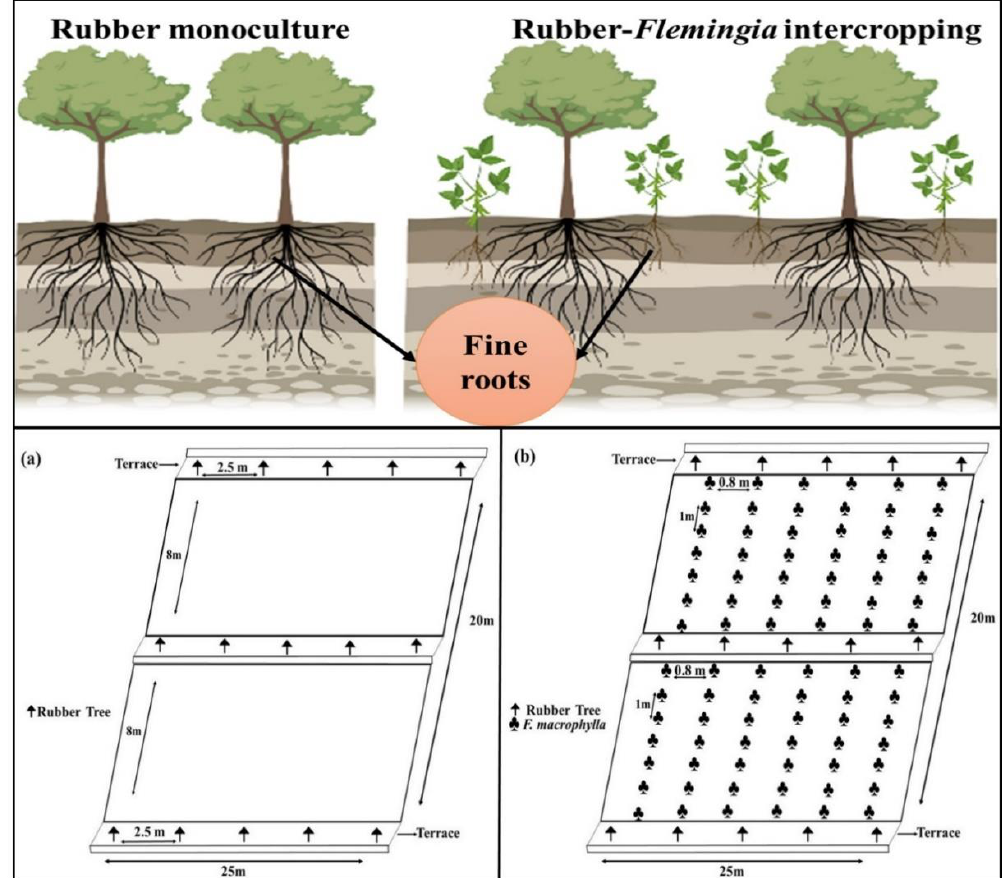
Figure 3. Schematic layout of plants in the specification in ( a ) rubber monoculture and ( b ) rubber- F. macrophylla intercropping. Table 4. Basic characteristics of plots.